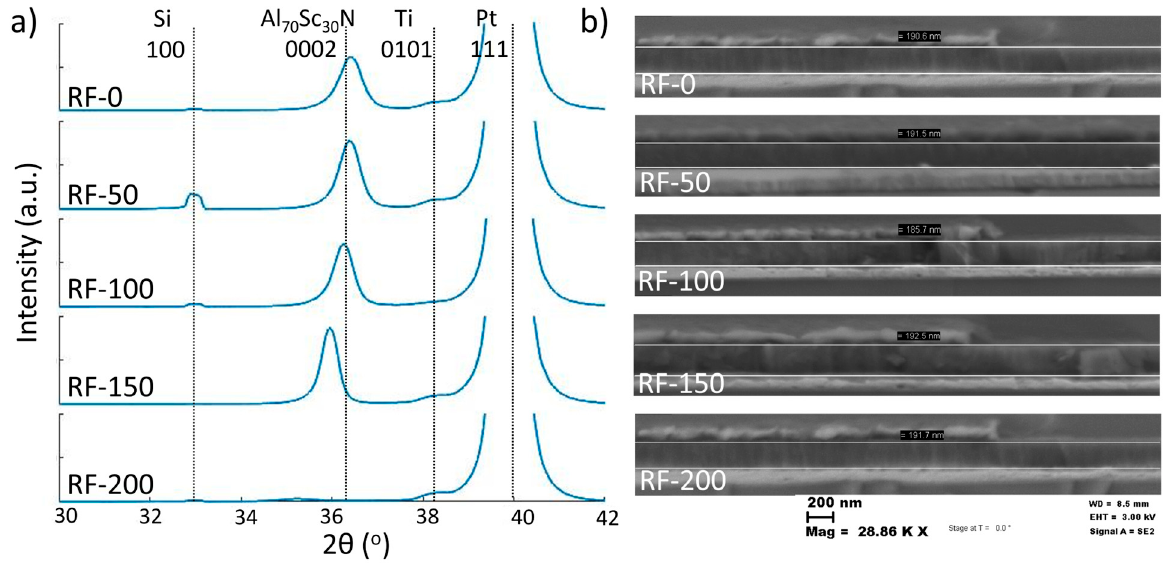
Figure 2. ( a ) Gonio-scan of the five samples showing the induced shifts of the 0002 AlScN plane. The dotted line represents the theoretical reference [18]. ( b ) SEM cross-sections of the samples with an average thickness of 190